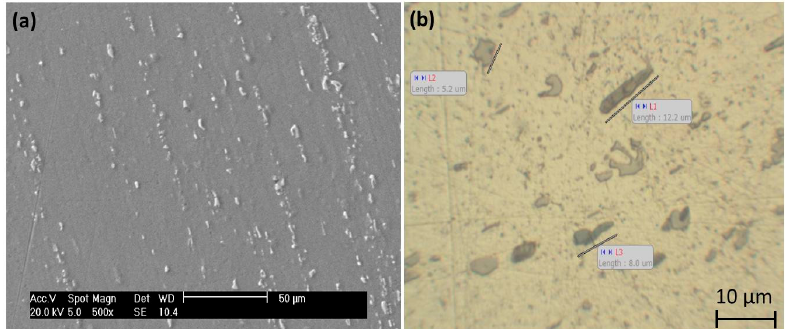
Figure 2. Microstructure of the substrate 6082-T6 aluminum alloy in ( a ) SEM polished